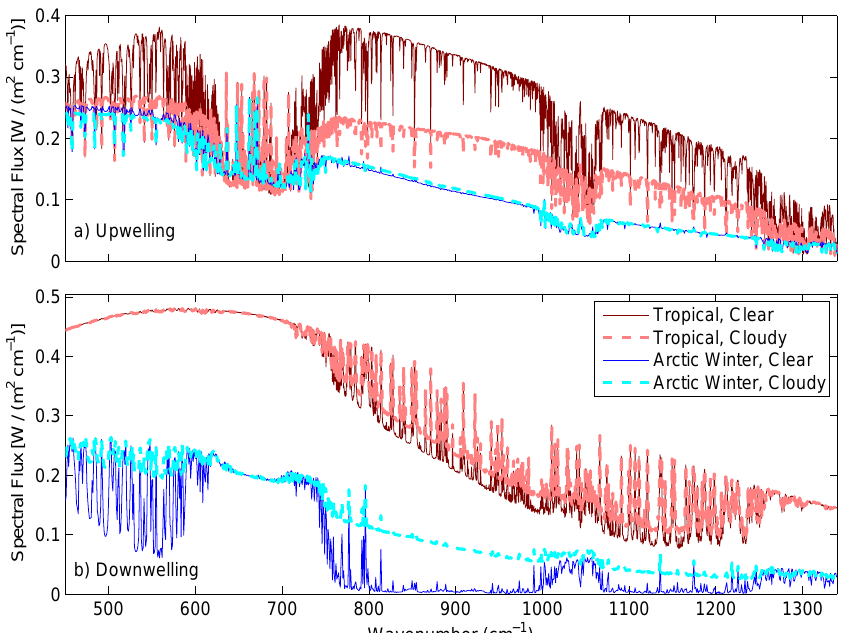
Fig. 2. Spectral fluxes from clear and cloudy skies for a warm/wet extreme model atmosphere (tropical) and a cold/dry extreme model atmosphere (Arctic winter). (a) Flux upwelling to the top of atmosphere and (b) flux downwelling to the surface. Plots are on a 1 wave- number spacing. The model cloud is a single-layer liquid cloud with effective radius of 10µm, and cloud liquid water path of 8gm − 2 , at a temperature of 240K, created using a conventional complex refractive index based on measurements made at